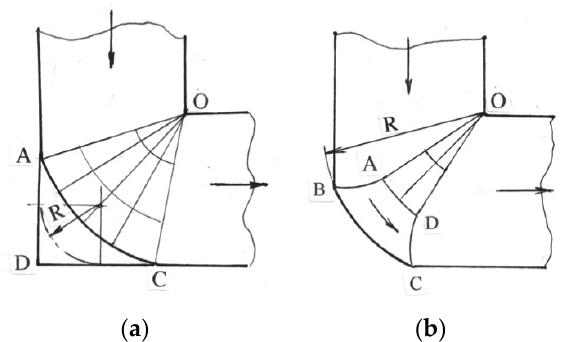
Figure 2. Slip-line fields for ECAE with friction through sharp-corner ( a ) and round-corner ( b ) channels.